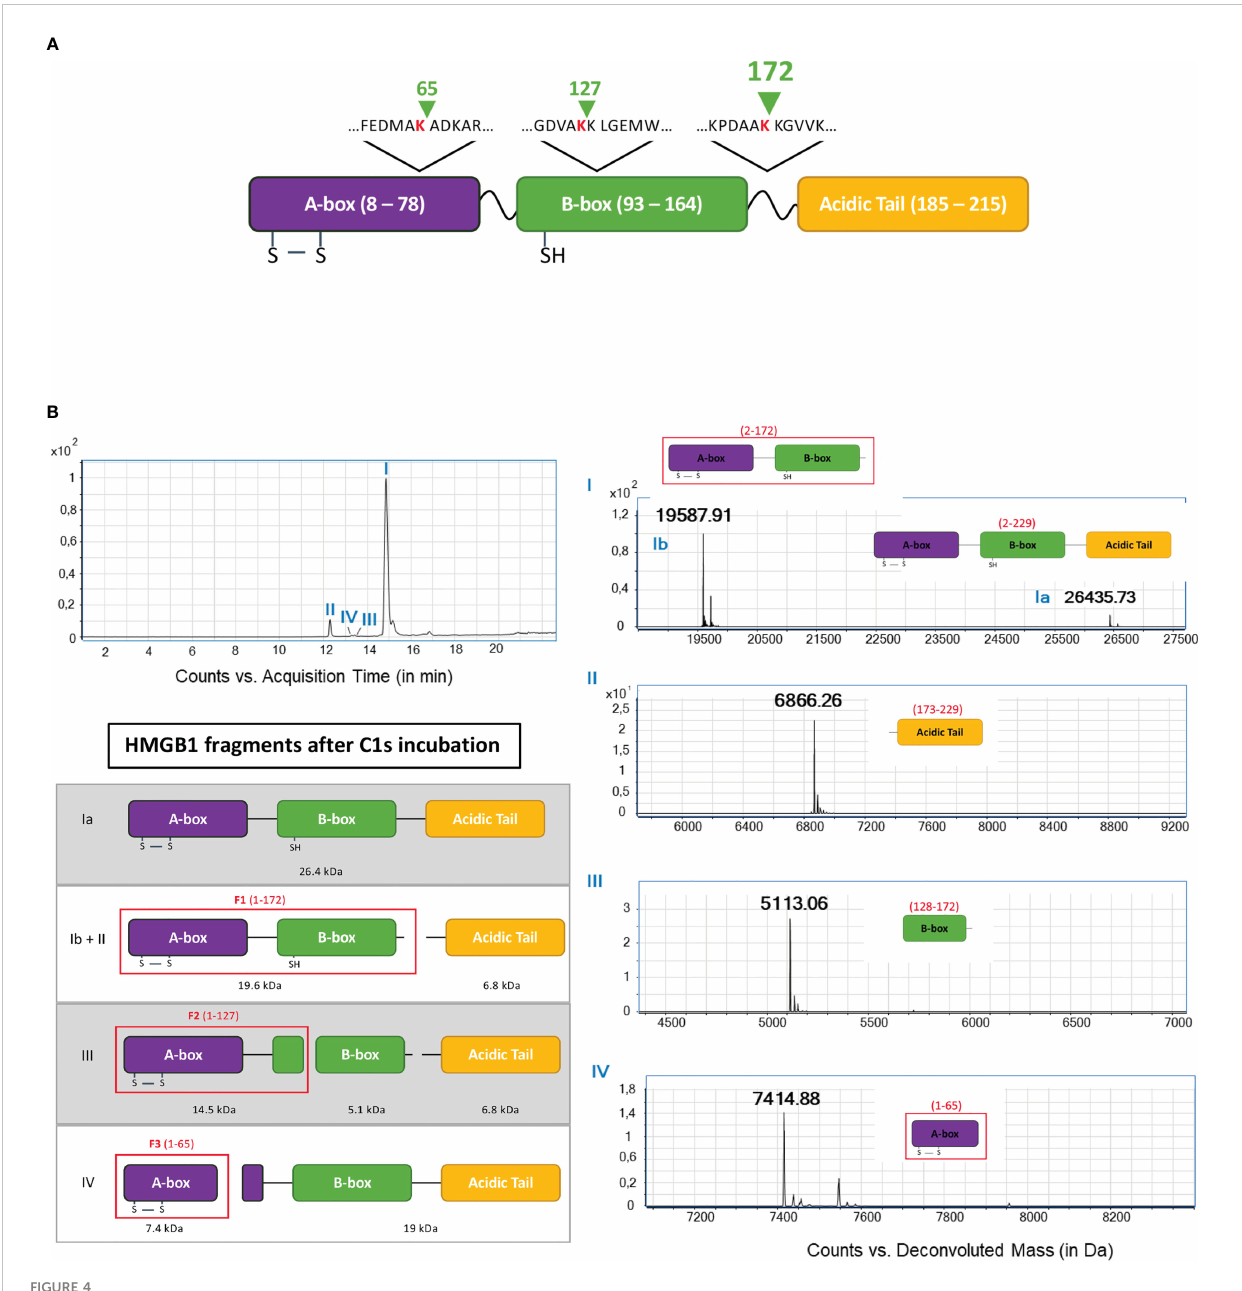
FIGURE 4 Fine LC/ESI mass spectroscopy analysis of HMGB1 incubated with C1s (A) . The cleavage sites deduced from the MS analysis are shown above the HMGB1 modular structure (green arrow shows where C1s cleavage occurs) (B) . The left MS panel shows an overview of the global spectrum with 4 peaks (I - IV). Peak I is subdivided into a main peak (Ib) at 19.6 kDa, corresponding to the mass of the 2-172 (F1) fragment, and a smaller peak (Ia) at 26.4 kDa, corresponding to undigested HMGB1. Peak II corresponds to the second product of the primary cleavage after K172, namely the C- terminal fragment (seq. 173 - 229) with a molecular weight of 6.8 kDa. Peak III comprises a fragment of the B-box (seq. 128 - 172) at 5.1 kDa. Peak IV corresponds to a fragment of the A-box (seq. 2 - 65) with a mass of 7.4 kDa. The left interpretation panel shows the attribution of the N-terminal fragments F1 - F3 within the HMGB1 frame: F1 corresponds to the sequence 1 - 172, F2 fi ts with the sequence 1 - 127 and F3 is the sequence 1 -